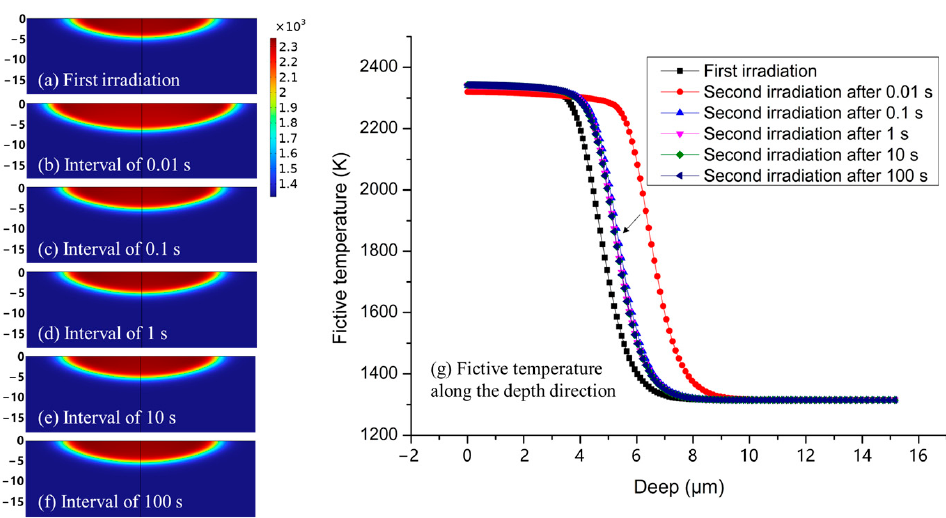
Figure 6. Fictive temperature distribution after ( a ) the first laser irradiation and after the second laser irradiation at time intervals of ( b ) 0.01 s, ( c ) 0.1 s, ( d ) 1 s, ( e ) 10 s, and ( f ) 100 s, respectively. ( g ) The fictive temperature distribution curve for the center of the incident point along the depth direc- tion.